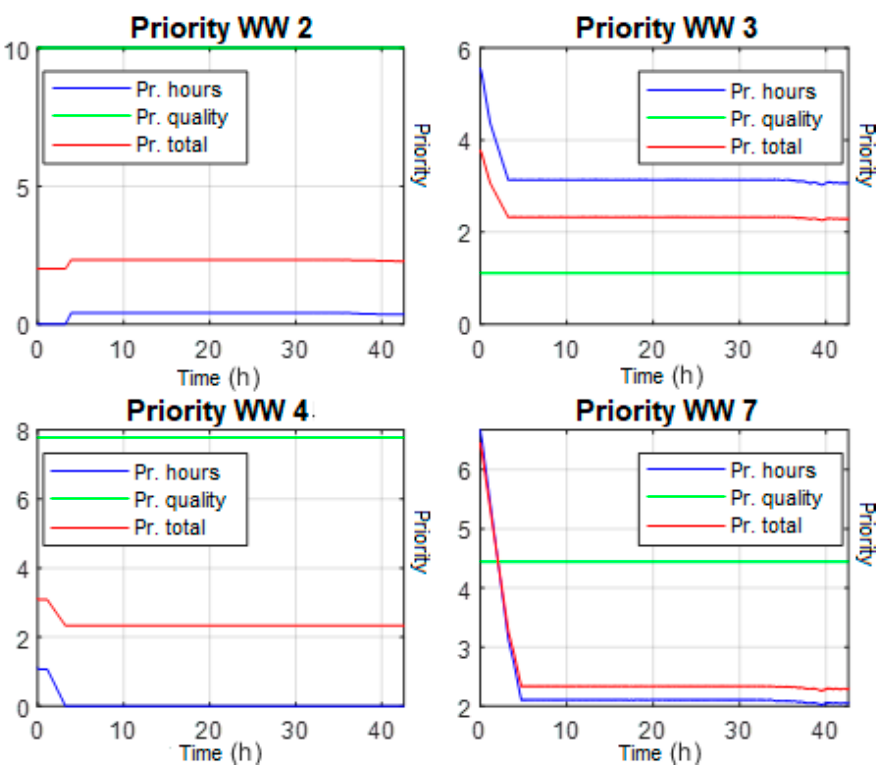
Figure 8. Water wells priority indicators in the test scenario.